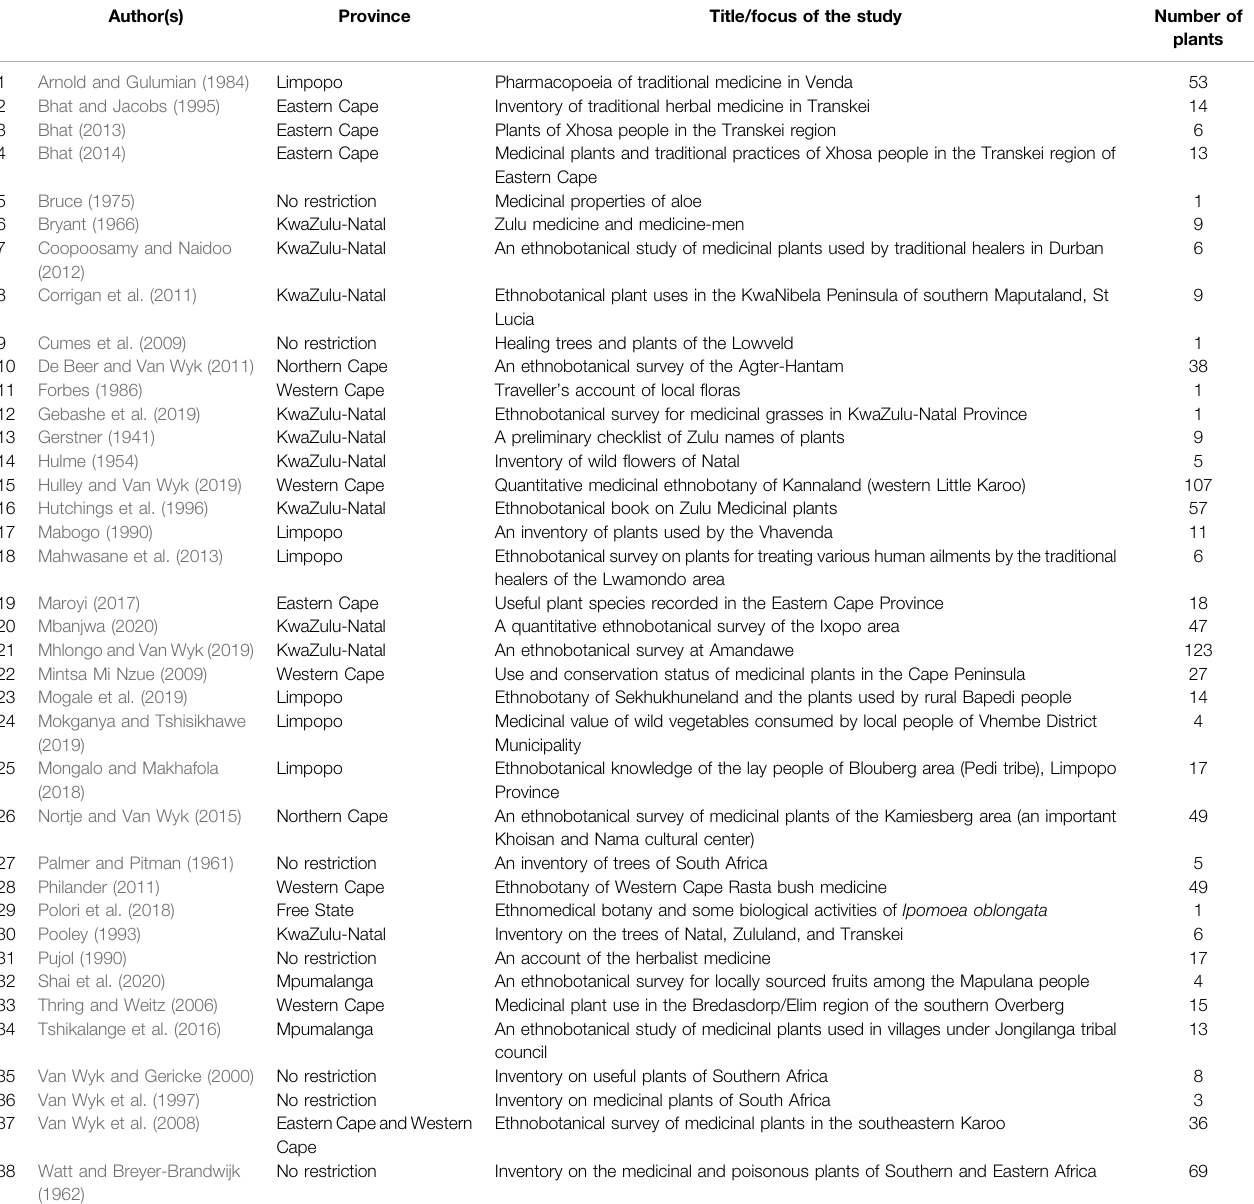
TABLE 1 | Overview of literature documenting the use of medicinal plants for managing and treating pain and in fl ammatory-related conditions in South Africa.